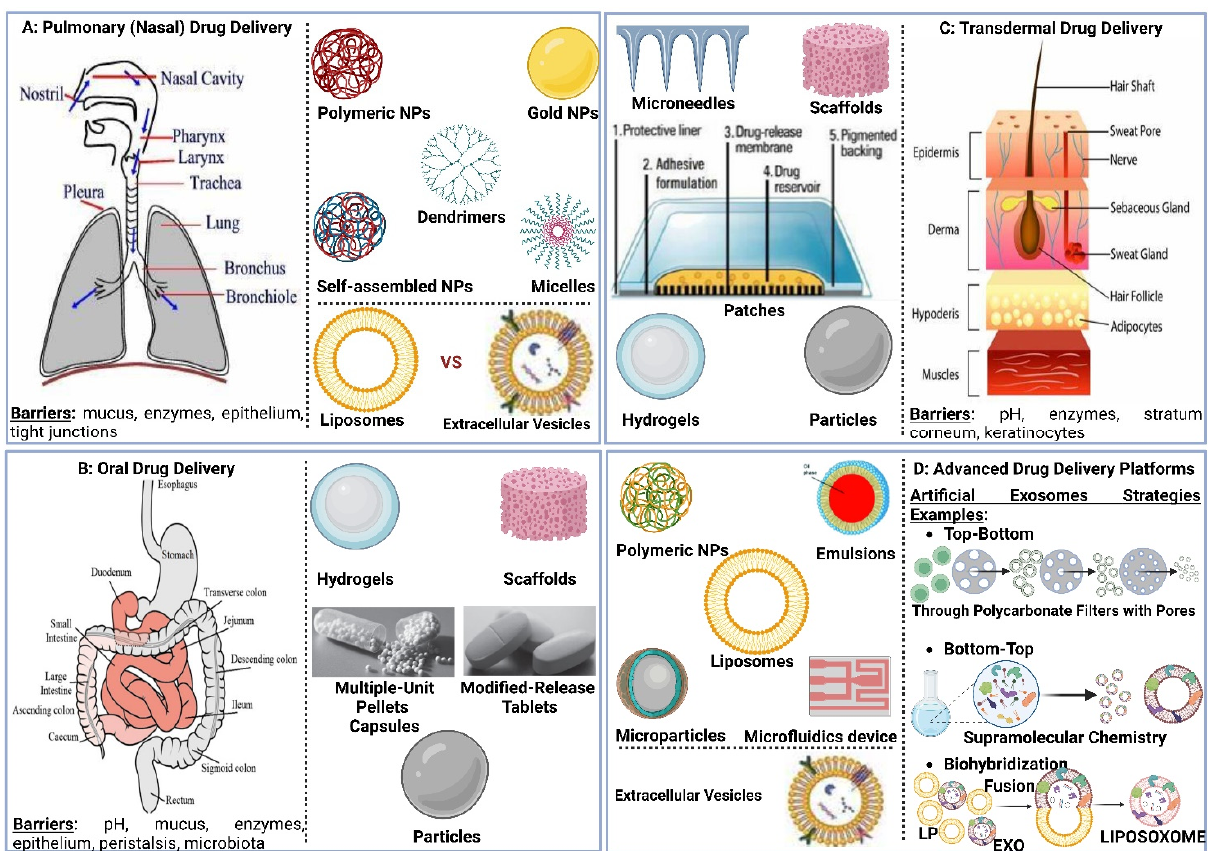
Figure 6. Advanced drug delivery platform technologies to improve the route of administration compliance: ( A ) Pulmonary drug delivery platforms. ( B ) Oral drug delivery platforms. ( C ) Transdermal drug delivery platforms. ( D ) Advanced drug delivery platforms.